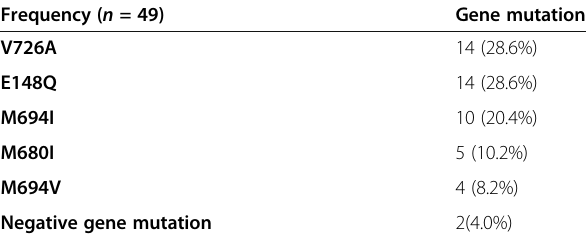
Table 7 Type of gene mutation of FMF patients with arthritis ( n =